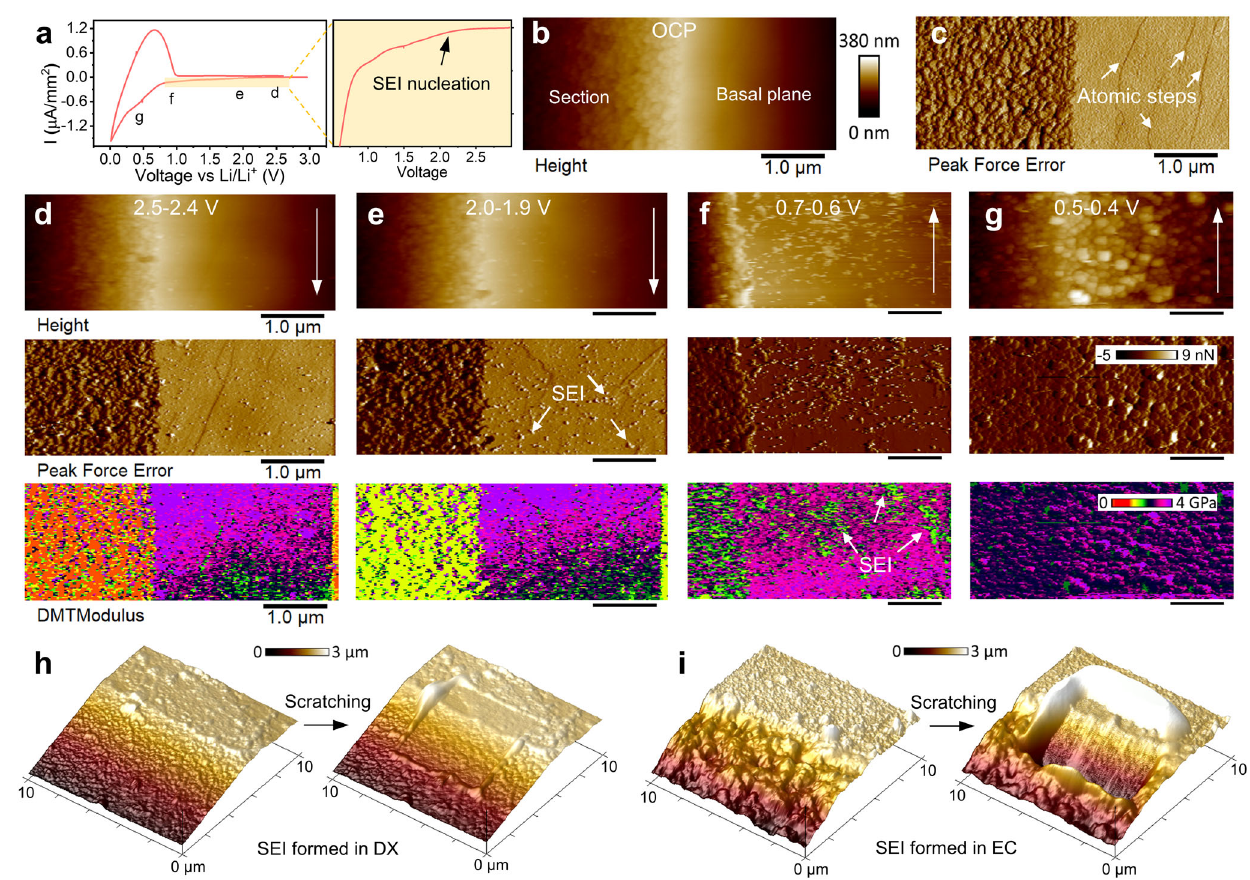
Fig. 3 | SEI formation and mechanical property on the graphite model sample sectionandbasalplanesintheweaklysolvatingelectrolyte(WSE) − 1MLiFISin 1,4-Dioxane. a 1st CV scan curve of HOPG sample, 0.5mV/s. b Topography and c peak force error images of the sample in the electrolyte at open circuit potential (OCP). d – g Topography,peakforceerrorandDMTmodulusonsamplesectionand